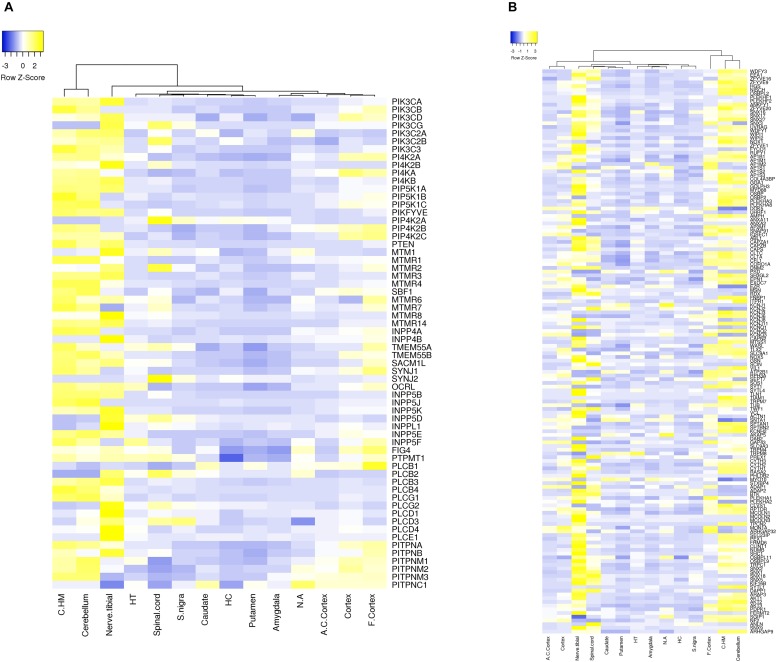
Expression of phosphoinositide signaling genes across human brain regions. A heat map showing the expression patterns. Data were extracted from the GTEx database. The expression values of genes for each of the brain region is normalized to the expression value of the gene in whole blood and the matrix thus obtained is represented as a heatmap. The normalized expression values range from –3 to 3 (Blue to Yellow). The map is clustered based on expression of genes in different regions of the Brain (across the column). The various brain regions represented are Cerebellar Hemisphere (C.HM), Cerebellum, Nerve tibial (N. tibial), Hypothalamus (HT), Spinal cord, Substantia nigra (S. nigra), Caudate, Hippocampus (HC), Putamen, Amygdala, Nucleus accumbens (N. accumbens), Anterior cingulate cortex (A. C. cortex), Cortex and Frontal cortex (F. cortex). Panel (A) shows the expression of kinases, phosphatases, phospholipases and lipid transfer protein while (B) shows the expression of phosphoinositide binding proteins. Individual proteins are indicated using HUGO nomenclature.